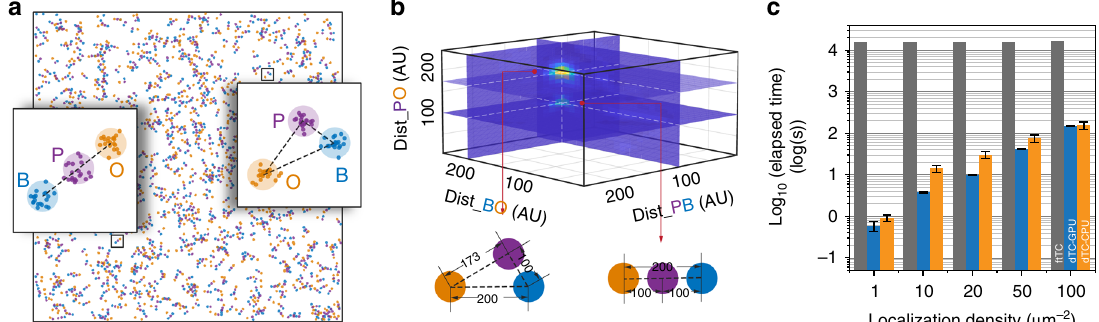
Fig. 2 Validation of the dTC algorithm on simulated SMLM data. a Simulated three-color single-molecule localization image in which two different molecular patterns were mixed rand randomly orientated. ~ 1000 such patterns in total were seeded onto 10240 × 10240 nm 2 canvas, and each pattern has ~10 localizations in each channel. b The triple-correlation pro fi le in which two local maxima were found representing the two input geometric con fi gurations. c Comparison between the ftTC and dTC algorithm in computing the triple-correlation. Three-color images of the same canvas size (10,240 × 10,240nm 2 ) but different molecular densities were submitted for dTC computation. These coordinates were rendered onto 2048 × 2048 pixelized image (pixel size = 5 × 5 nm 2 ) for ftTC computation. Error Bars in dTC computation stands for the SD of fi ve computation replicates while ftTC computation was only performed once due to its computational costs. Source data for Fig. 2c are provided as a Source Data fi le